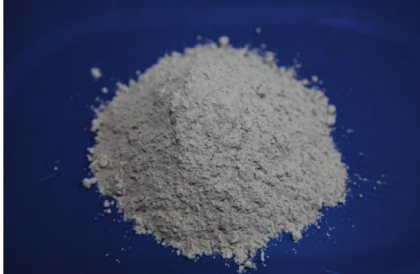
Figure 14: Bentonite.